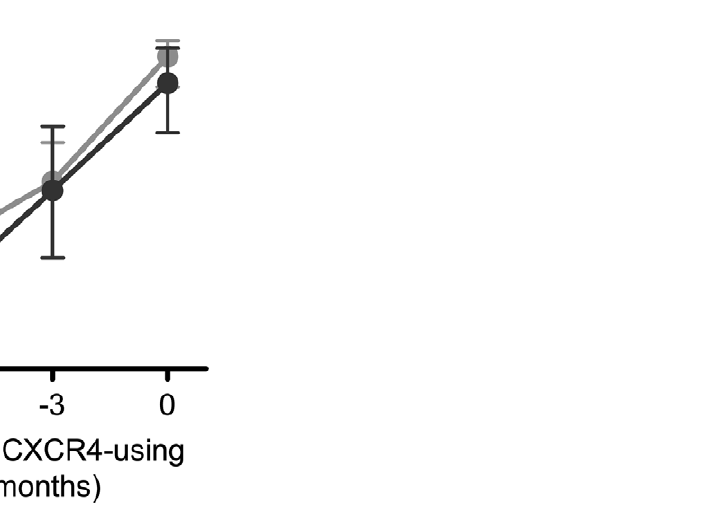
Figure 2. Increasing percentage of predicted CXCR4-using variants over time following their appearance during natural HIV-1 infection. The median percentage si/x4 sequences generated from PBMC (light grey) and serum (dark grey) by deep sequencing at time points up to one year before the first phenotypic detection of CXCR4-using variants in the MT-2 assay in eight participants are shown. Error bars represent the interquartile